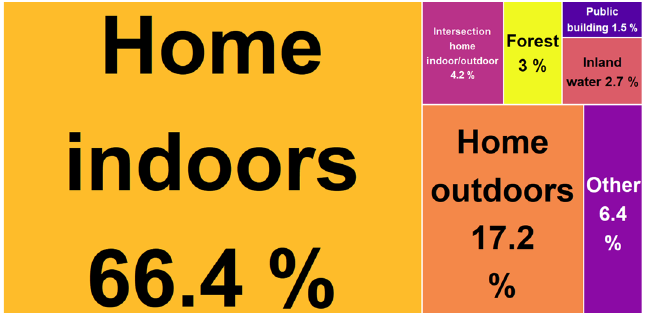
Figure 3. Proportional treemap of categorised participants’ biotope information showing the overrepresentation of submissions from private surroundings. Only biotopes with portions ≥ 1.5% are presented individually, categories with a smaller share have been combined into ‘other’. Plotted with package treemap in R version 3.5.2.